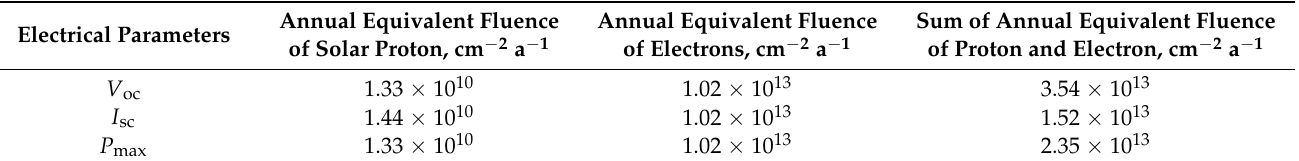
Table 4. Equivalent fluence per year for GaInP/GaAs/Ge PV cells irradiated by the solar protons and the radiation belt electrons in the geosynchronous